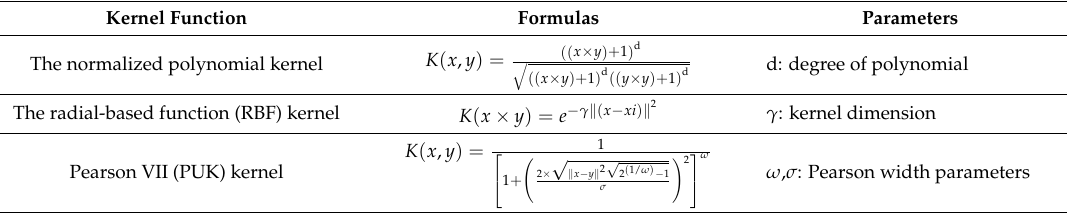
Table 2. The kernel functions and parameters used in support vector machine (SVM).